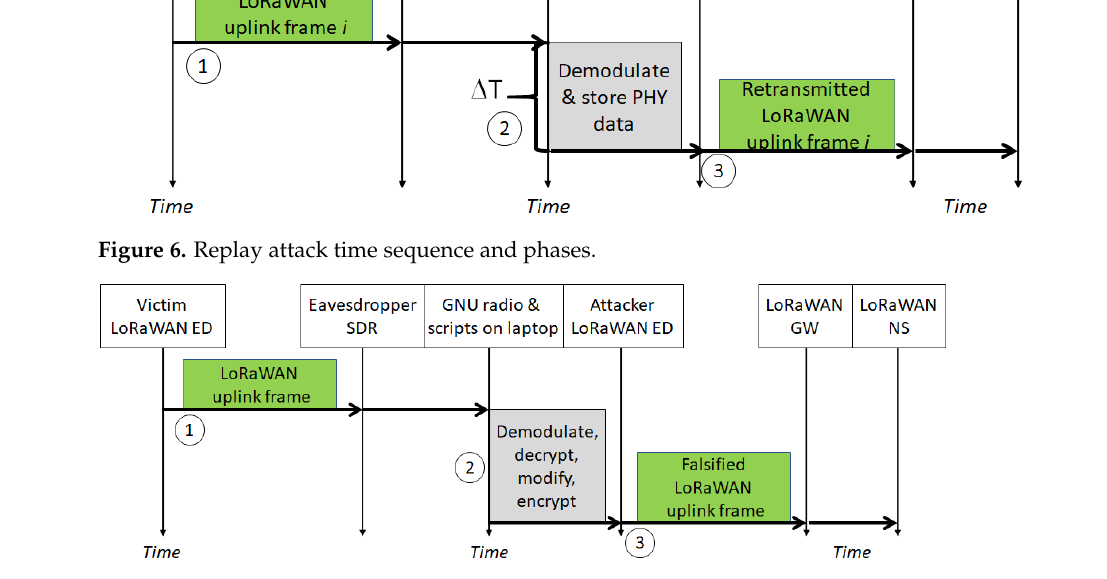
Figure 7. Bit-flipping attack time sequence and